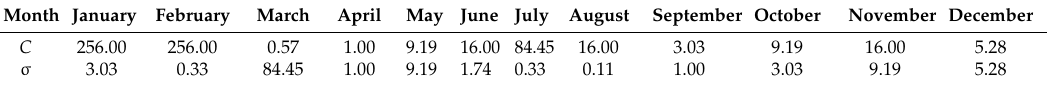
Table 6. The monthly optimal values of C and σ of LSSVM using PSO algorithm.